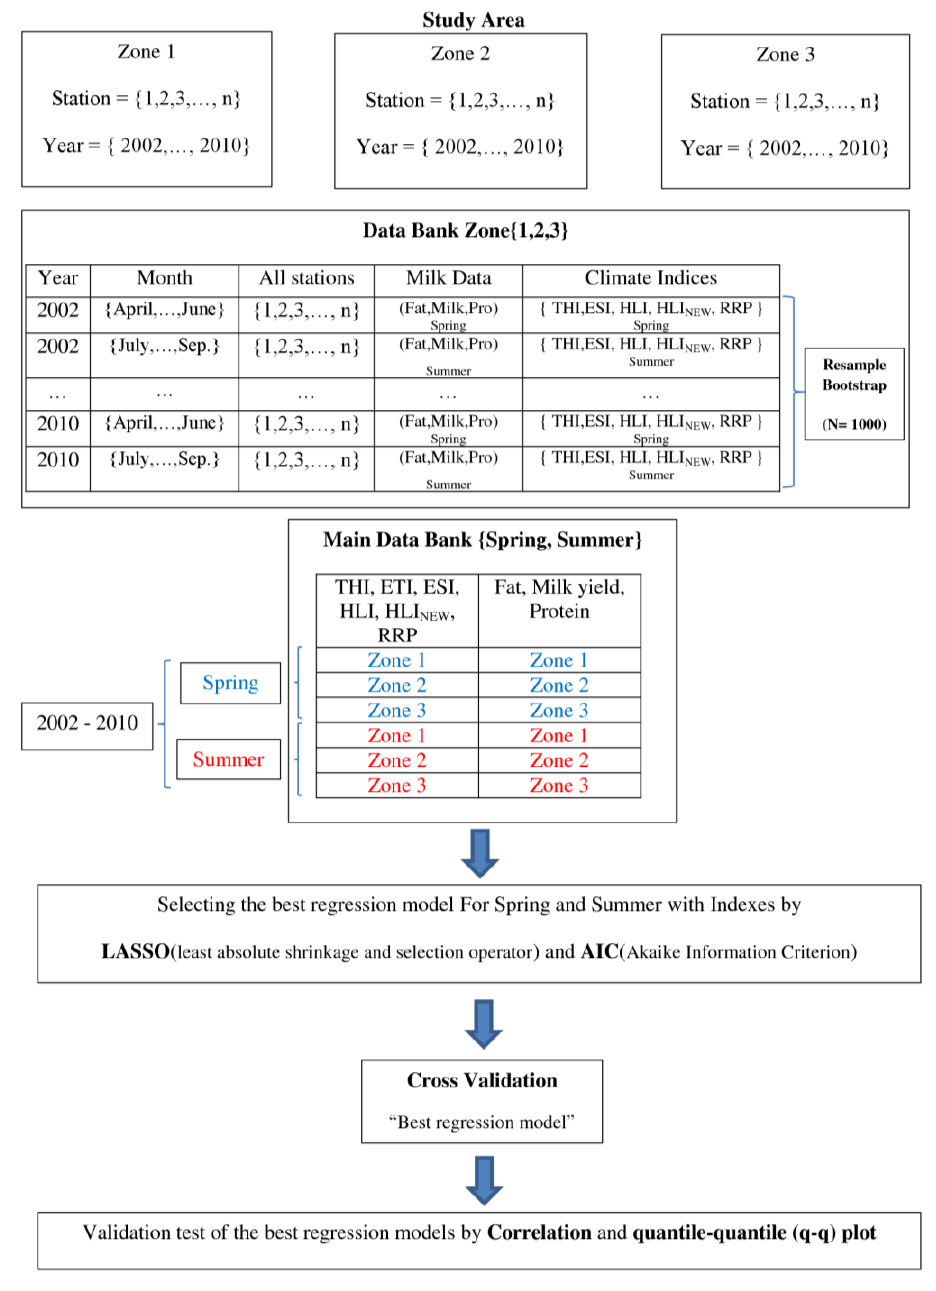
Figure 2. The flowchart of the data set of climatic and milk parameters and methodology.